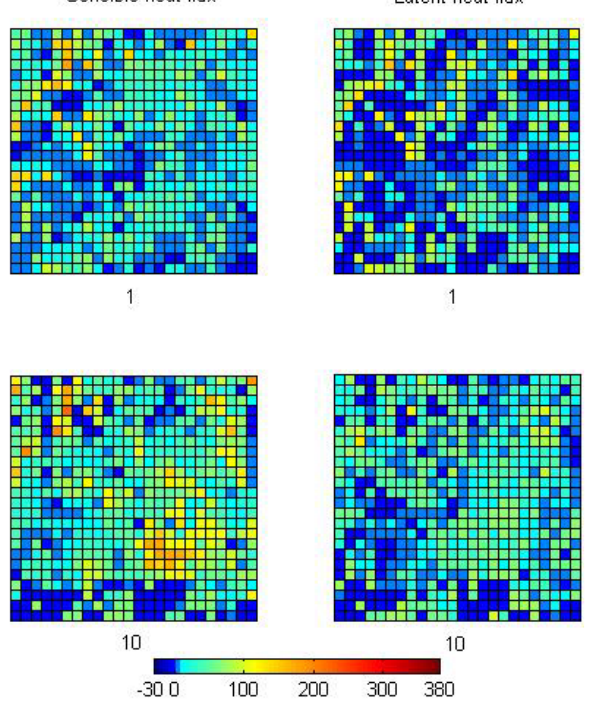
Figure 11. The difference in sensible ( left ) and latent heat fluxes ( right ) when using RAMS and CORINE land-cover data (CORINE values—RAMS